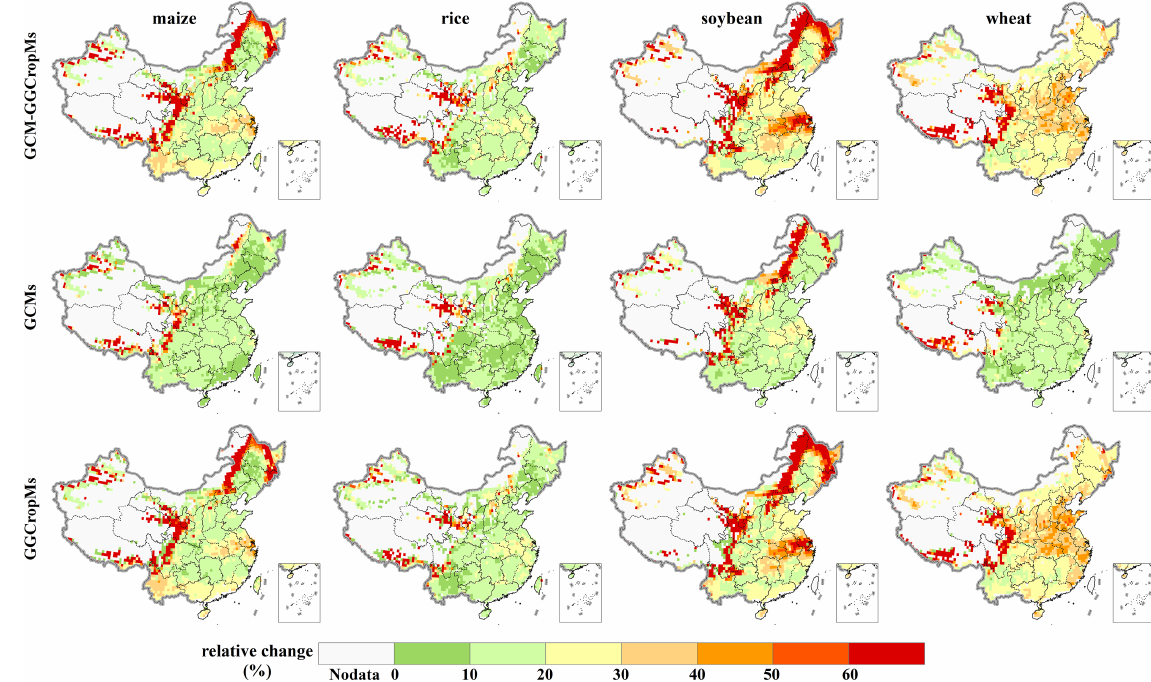
Figure 10. The model spread of the relative change in the simulated yield of maize, rice, soybean and wheat with the CO 2 effect at the end of the 21st century (top row) and the model spread induced by GCMs (middle row) and GGCropMs (bottom